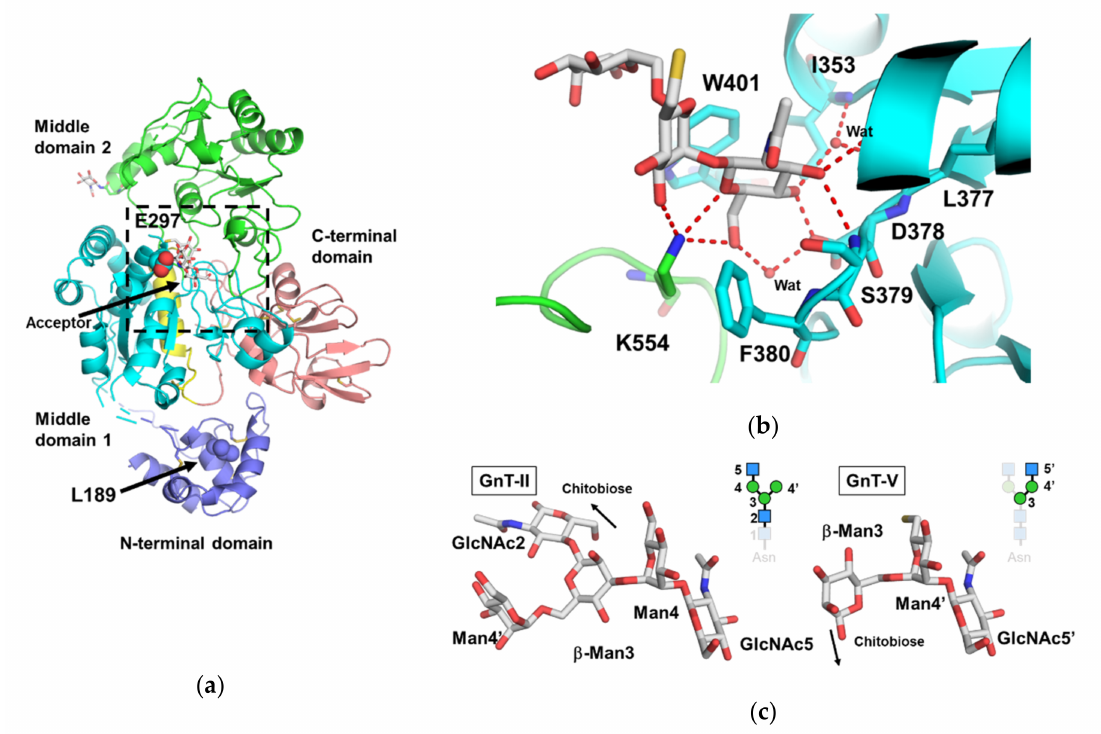
Figure 4. Crystal structure of human GnT-V. ( a ) Overall structure of the human GnT-V luminal domain (PDB code: 5ZIB). The N-terminal domain, middle domain 1, 2, and C-terminal domain are colored in blue, cyan, green, and pink, respectively. The short insertion in middle domain 1 is colored in yellow. The position of the acceptor N -glycan was obtained by superposition of the mini-GnT-V-glycan complex (PDB code: 5ZIC). Two important residues (L189 and E289) denoted in the text are shown as sphere models. The oxygen atoms of E289 are highlighted in red. The putative catalytic center is highlighted in the black dotted box. ( b ) Close up view of the acceptor N -glycan binding site (PDB code: 5ZIC). The direct and water-mediated hydrogen bonds are shown in red dotted lines. Two aromatic residues (F380 and W401), which may determine the branch specificity of GnT-V, are also shown. ( c ) Structural comparison between the GnT-II acceptor complex and GnT-V acceptor complex. The superposition is based on GlcNAc residues of both branches (GnT-II: α 1-3 branch, GnT-V: α 1-6 branch). The disaccharide units (GlcNAc β 1-2Man) of the two structures are well